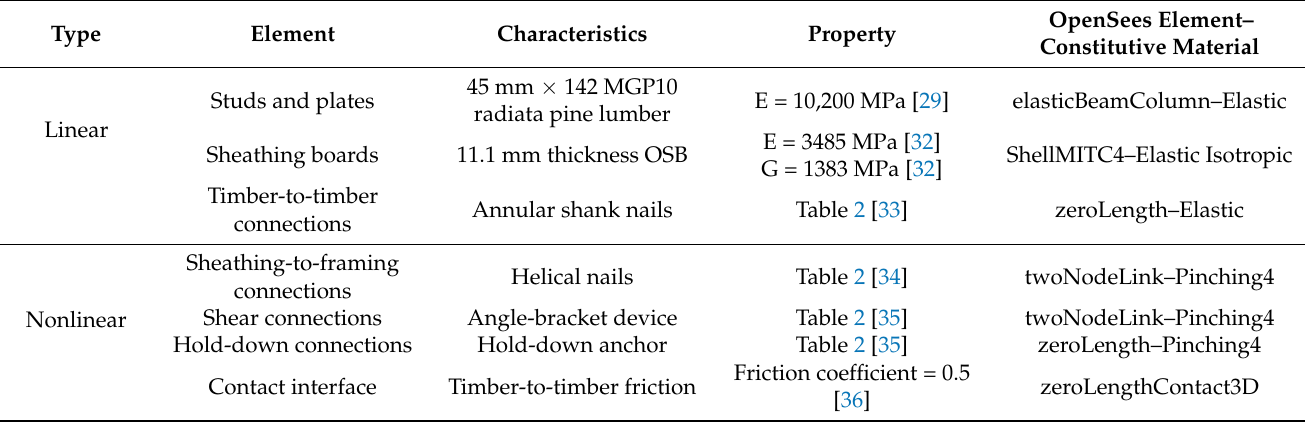
Table 1. Modeling properties of elements and connections.